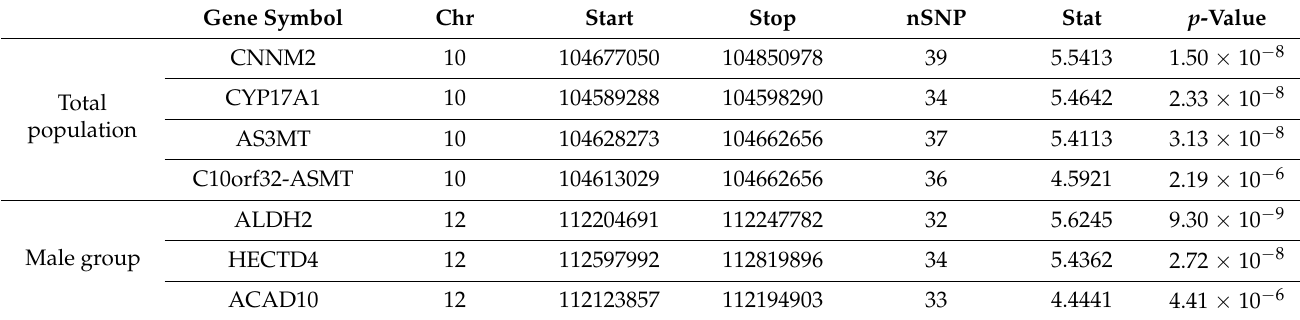
Table 2. Results of hypertension MAGMA analysis in the total and male